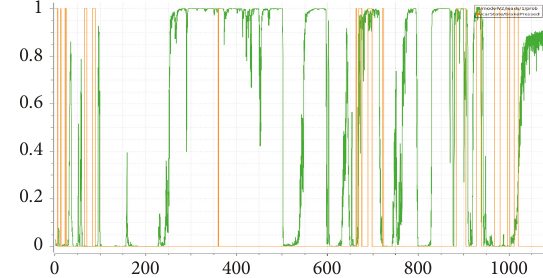
Figure 22: T1D5 lead car detection and braking.